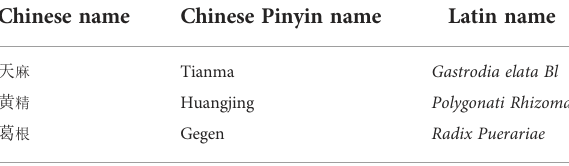
TABLE 7 Chinese and Latin names of Chinese medicines.